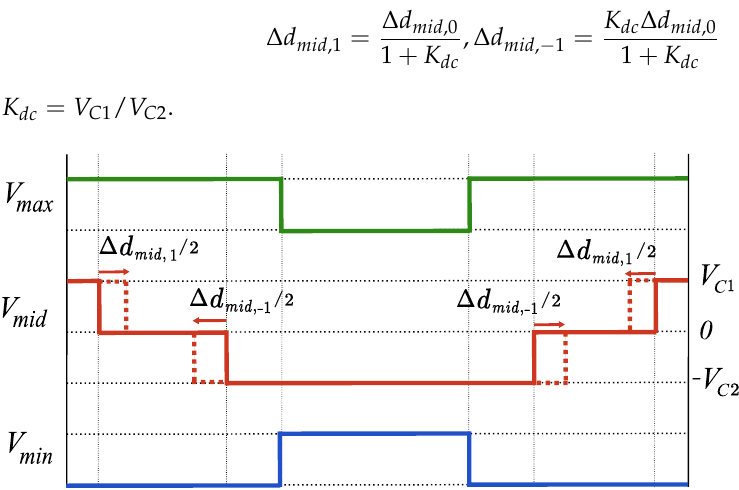
Figure 13. Adjusting the duty ratio of the median phase, u mid , for NPV